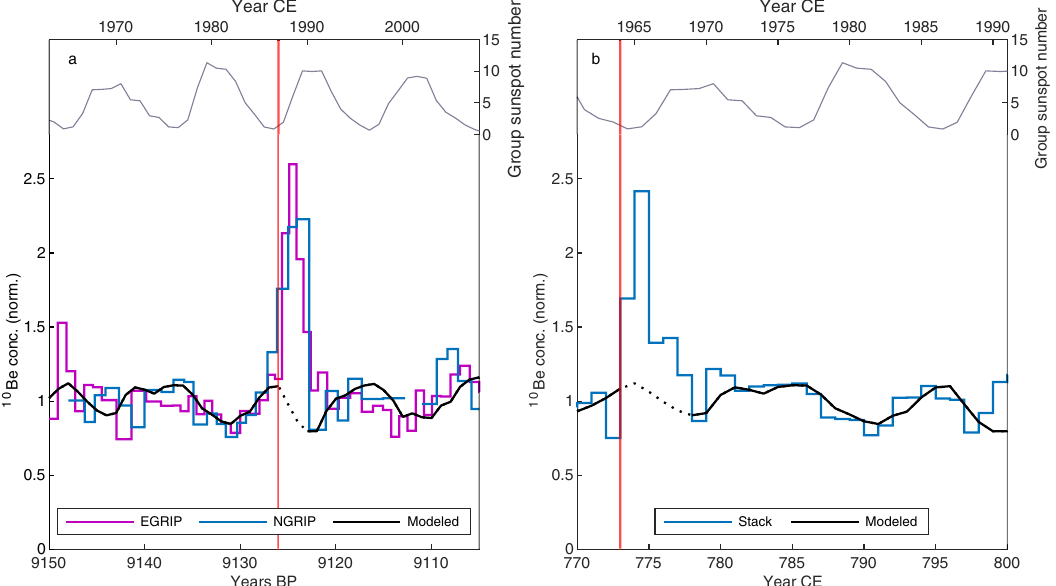
Fig. 3 Relationship between the solar 11-year cycle and the occurrence of the solar energetic particle events of 9125 years BP and 774/5 CE. a The normalized 10 Be records from NGRIP and EGRIP from 9150 to 9105 years BP (see legend) compared to the normalized 10 Be annual production rate modeled from neutron monitor data 11 for the period 1963 – 2008 (black line), showing the best correlation coef fi cients (for details see main text, EGRIP: r = 0.45, p < 0.01; NGRIP: r = 0.51, p < 0.01). The top panel shows the group sunspot number corresponding to the period of the neutron monitor-based production rate 49 . b The same comparison for the average 10 Be data from ice cores from Greenland (NEEM S1, NGRIP, and Tunu) and Antarctica (WAIS) from 770 to 800 CE (blue line) to the period 1961 – 1991 (neutron-monitor based production rate, black line), showing the best correlation coef fi cient (for details see main text, r = 0.69, p < 0.01). NEEM, NGRIP, and Tunu from Greenland and WAIS from Antarctica were normalized to their baseline (average 10 Be concentration excluding the peak). The red line indicates the estimated onset of the event. The timescales are independently matched 25,59 , i.e., not matched to get a fi t for the 10 Be